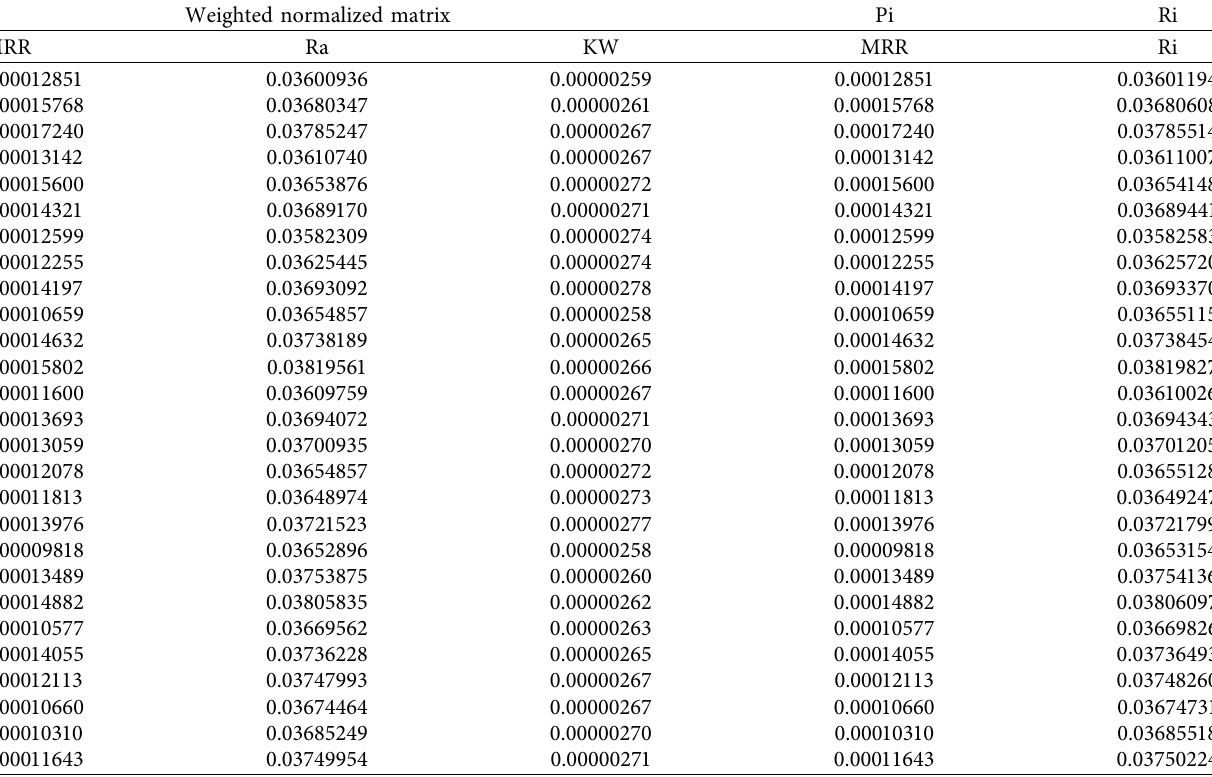
Table 11: Computed attributes values.